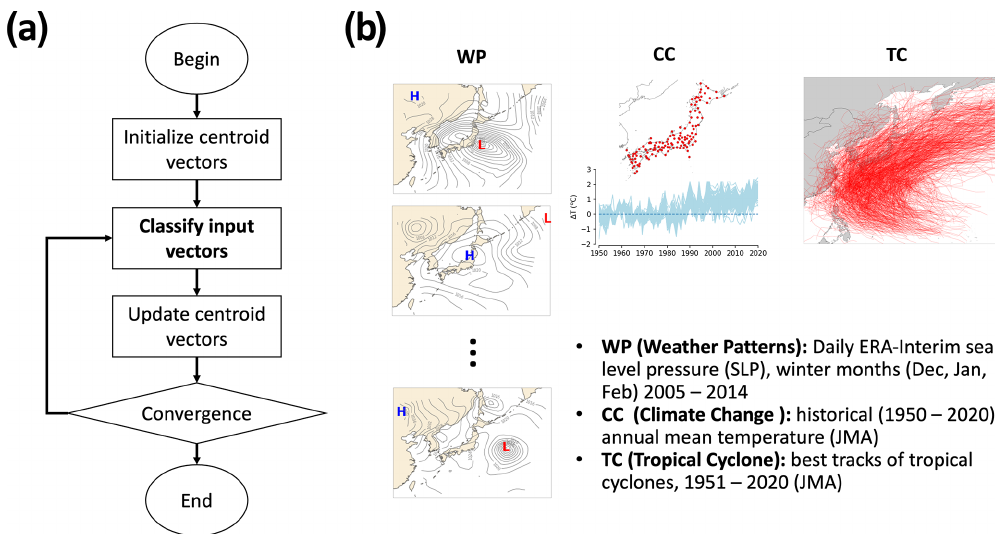
Figure 1. Illustration of the k -means clustering algorithm (a) and three demonstration experiments (b) . Demonstration experiments include clustering weather patterns (WPs) in terms of daily ERA-Interim sea level pressure (SLP) during winter months (December, January, and February) for 10 years (2005–2014) over the Japanese region, clustering climate change (CC) in terms of historical (1951–2020) annual- mean temperature collected from in situ weather stations in Japan, and clustering best tracks of tropical cyclones that passed the northwestern Pacific region from 1951–2020. Data were obtained from the Japan Meteorological Agency